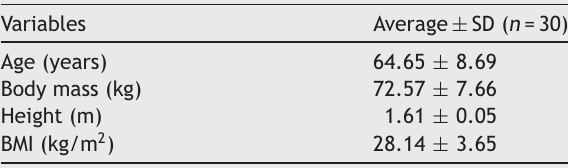
Table 1 Anthropometric characteristics of the evaluated